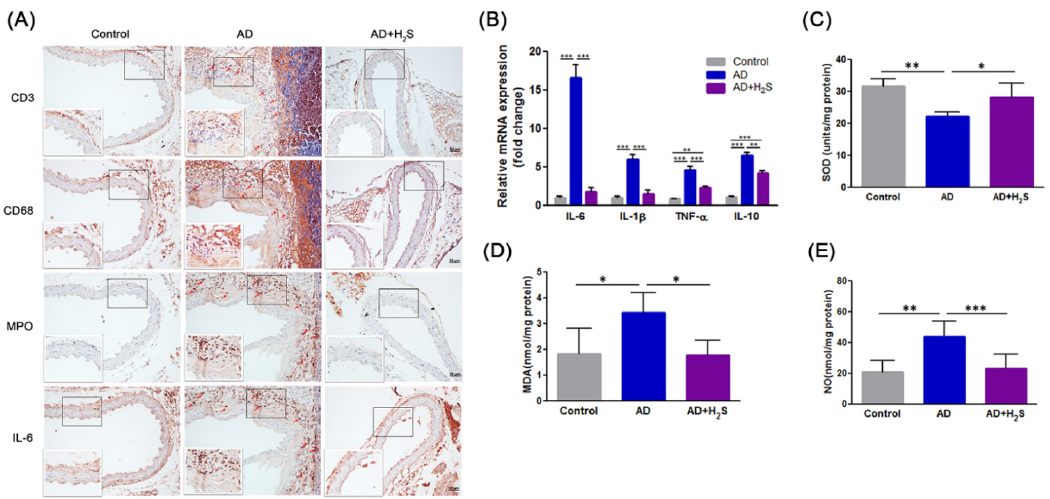
Figure 3. Administration of H 2 S reduced inflammatory response and oxidative stress in AD mice. ( A ) Representative immunohistochemical staining for T cells (CD3), macrophages (CD68), neutrophils (MPO), and IL-6 in transverse cryosections of aortas from mice ( n = 3 per group). Scale bar, 20 μ m. ( B ) RT–qPCR analysis of IL-6, IL-1 β , TNF- α , and IL-10 mRNA levels in the aorta ( n = 5 per group). ( C ) SOD activity, ( D ) MDA level, and ( E ) NO level were measured using aortic homogenates in each treatment group ( n = 5 pre group). The data are expressed as mean ± SD. Statistical significance: * p < 0.05, ** p < 0.01, *** p < 0.001.